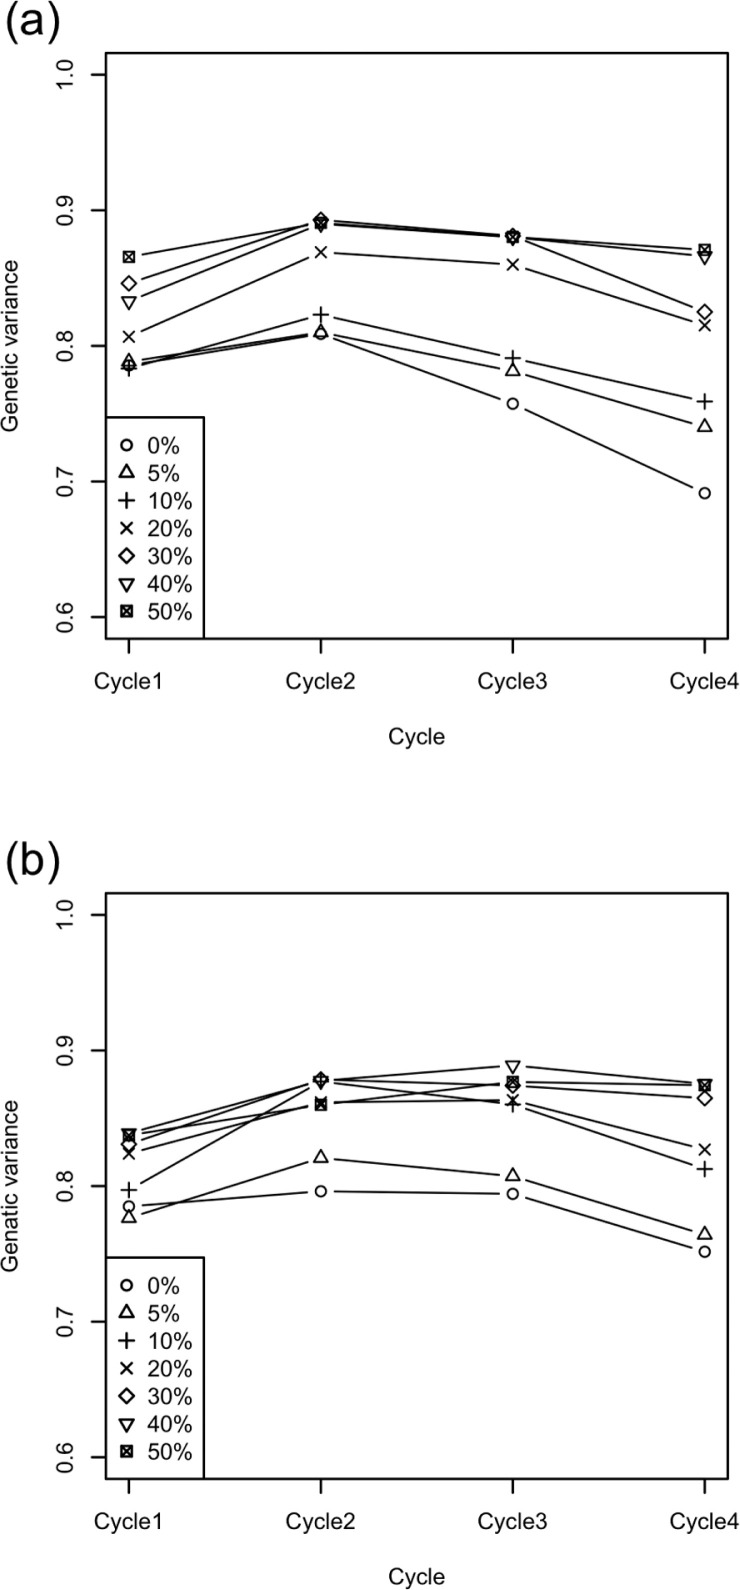
Genetic variance through four cycles of selection with source errors under (a) the seedling scheme vs. (b) the no-seedling scheme. Symbols indicate the mislabeling rates.